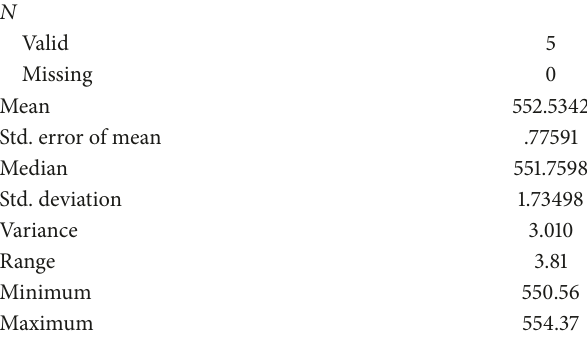
Table 11: The statistical results of reactor inlet temperature.